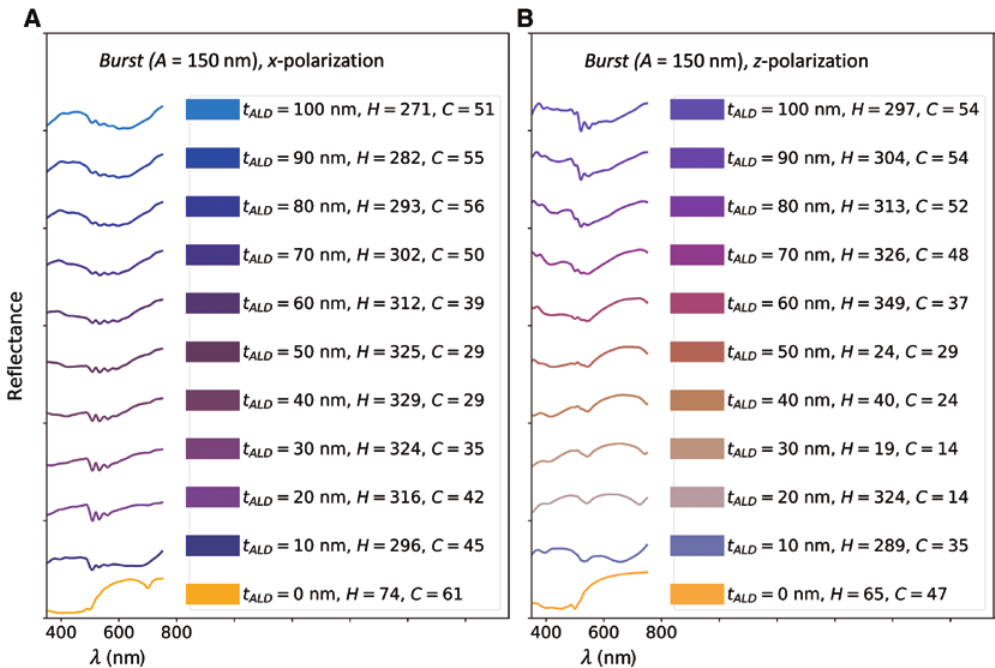
(burst for two incident linear polarizations). ALD = 0.3 R and D = 90 nm for (A) x -polarization and (B) z -polarization on a burst surface ( L emb m